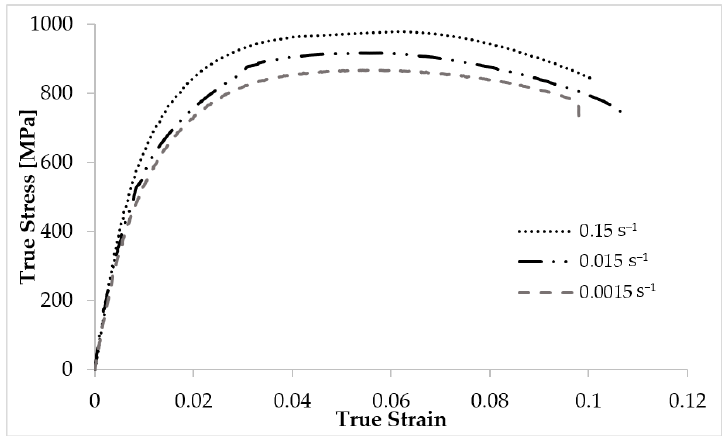
Figure 2. True stress-strain curves at room temperature and various strain rates.